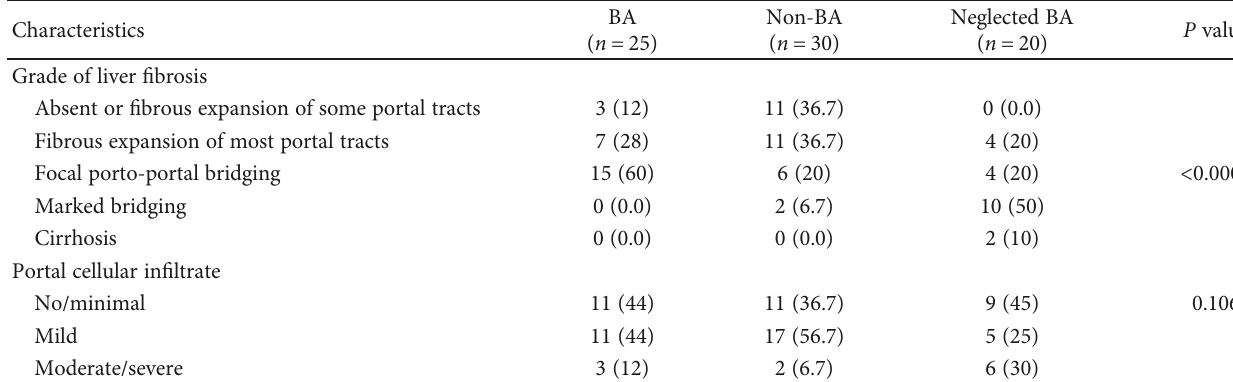
Table 2: Histopathological characteristics of the studied